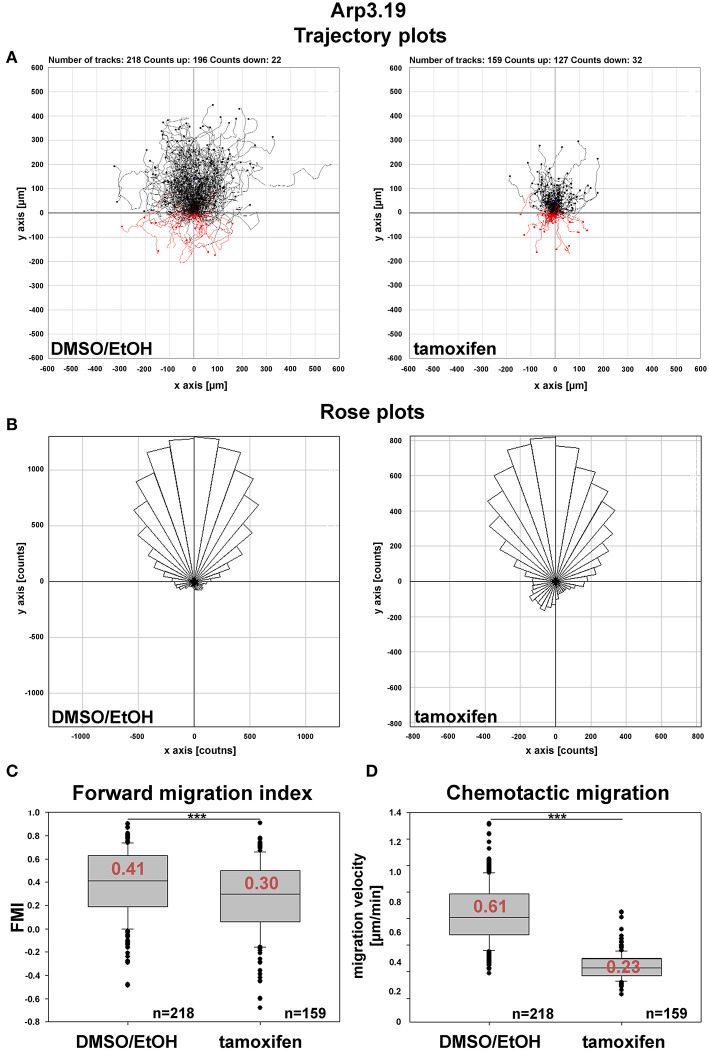
Arp2/3 complex contributes to, but is not essential for chemotaxis. (A) Trajectory plots of control (DMSO/EtOH)- and tamoxifen-treated MEFs (Actr3fl/fl clone Arp3.19) migrating toward a gradient of 2.5% serum and 100 ng/ml HGF. Data obtained from time-lapse microscopy (20 h) followed by manual tracking of cells in three independent experiments. (B) Rose plots with each 10° segment showing the frequency of migratory tracks in that particular direction. Note that both DMSO/EtOH- and tamoxifen-treated fibroblasts migrate toward the given gradient with increased frequencies. (C) Forward migration index (FMI) obtained from the two experimental conditions. The FMI is defined as displacement of the cell in the direction of the gradient divided by the total distance migrated. Again, Arp3-depleted fibroblasts display a slightly impaired directional persistence. (D) Quantification of rates of chemotactic migration. Velocity of chemotactic migration of Arp3-depleted cells is reduced to an extent similar to that observed in directed, wound healing migration assays. Box and whiskers plots in (C,D) were as described for Figure 4B. Statistics: Non-parametric Mann-Whitney rank sum test (***p < 0.001).